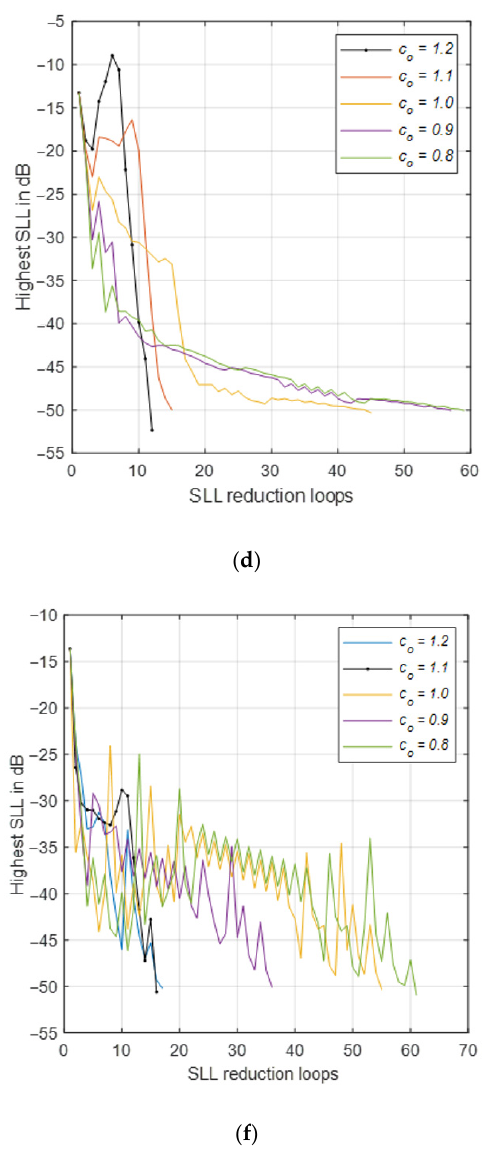
Figure 7. Convergence profile of the adaptive SSR learning curves at different initial damping factor with threshold damping factor of 0.5 and array size M of: ( a ) 16 elements, ( b ) 32 elements, ( c ) 64 elements, ( d ) 128 elements, ( e ) 256 elements, and ( f ) 512 elements.